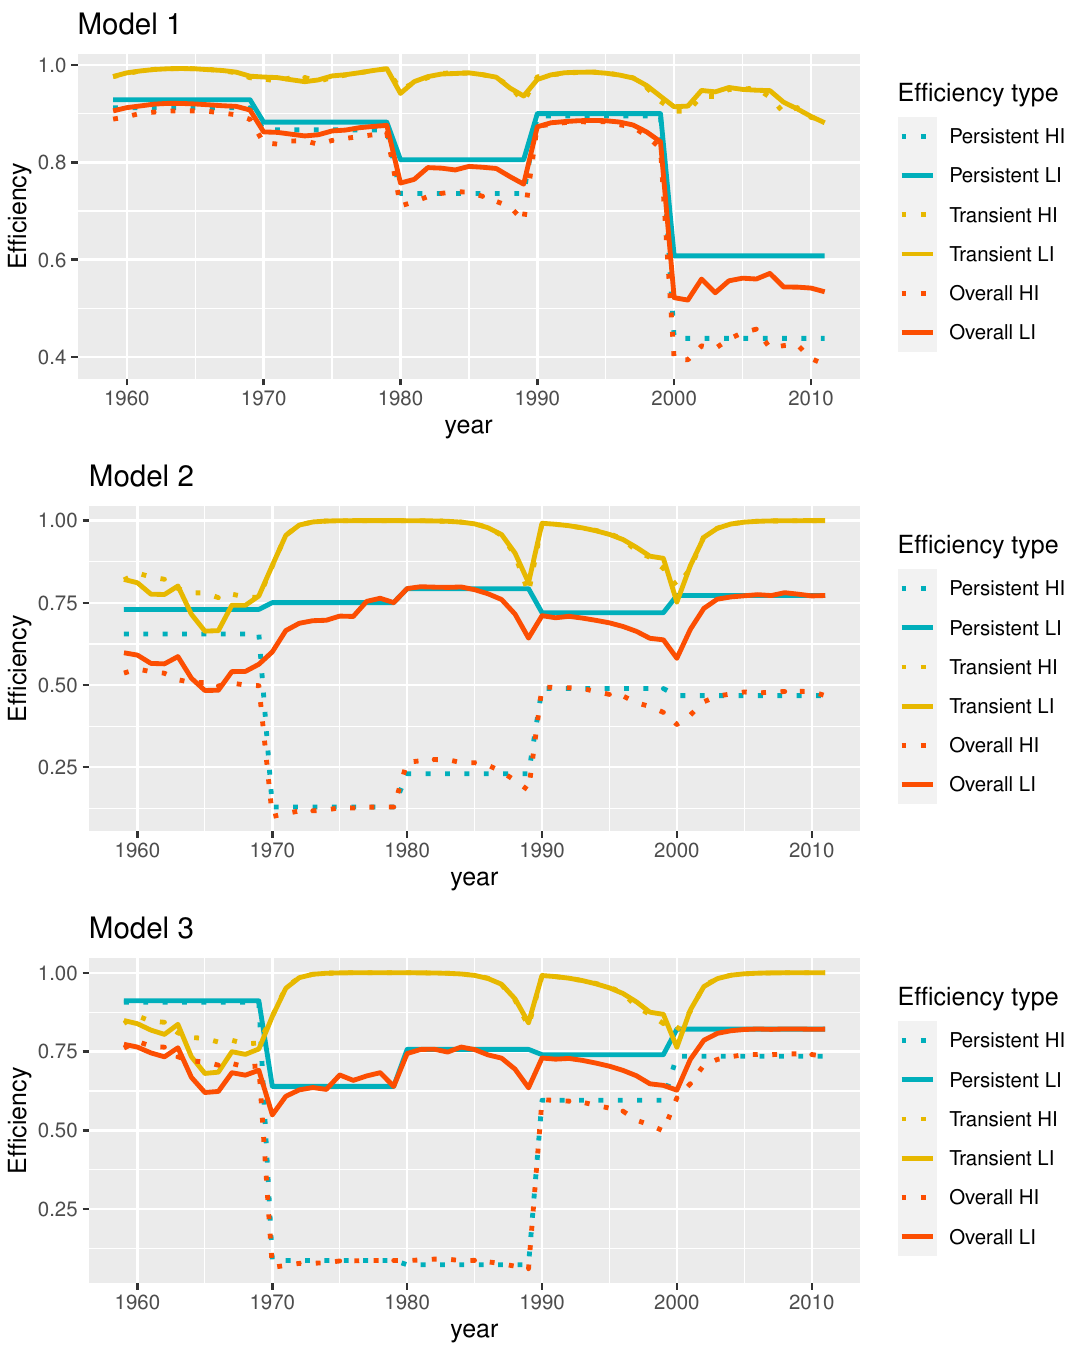
Figure 3. Average efficiency by year, energy intensity, and type of efficiency. The abbreviation HI stands for high intensity and LI means low intensity. Notes: The dotted time-series lines are for the high and solid lines are for low intensity